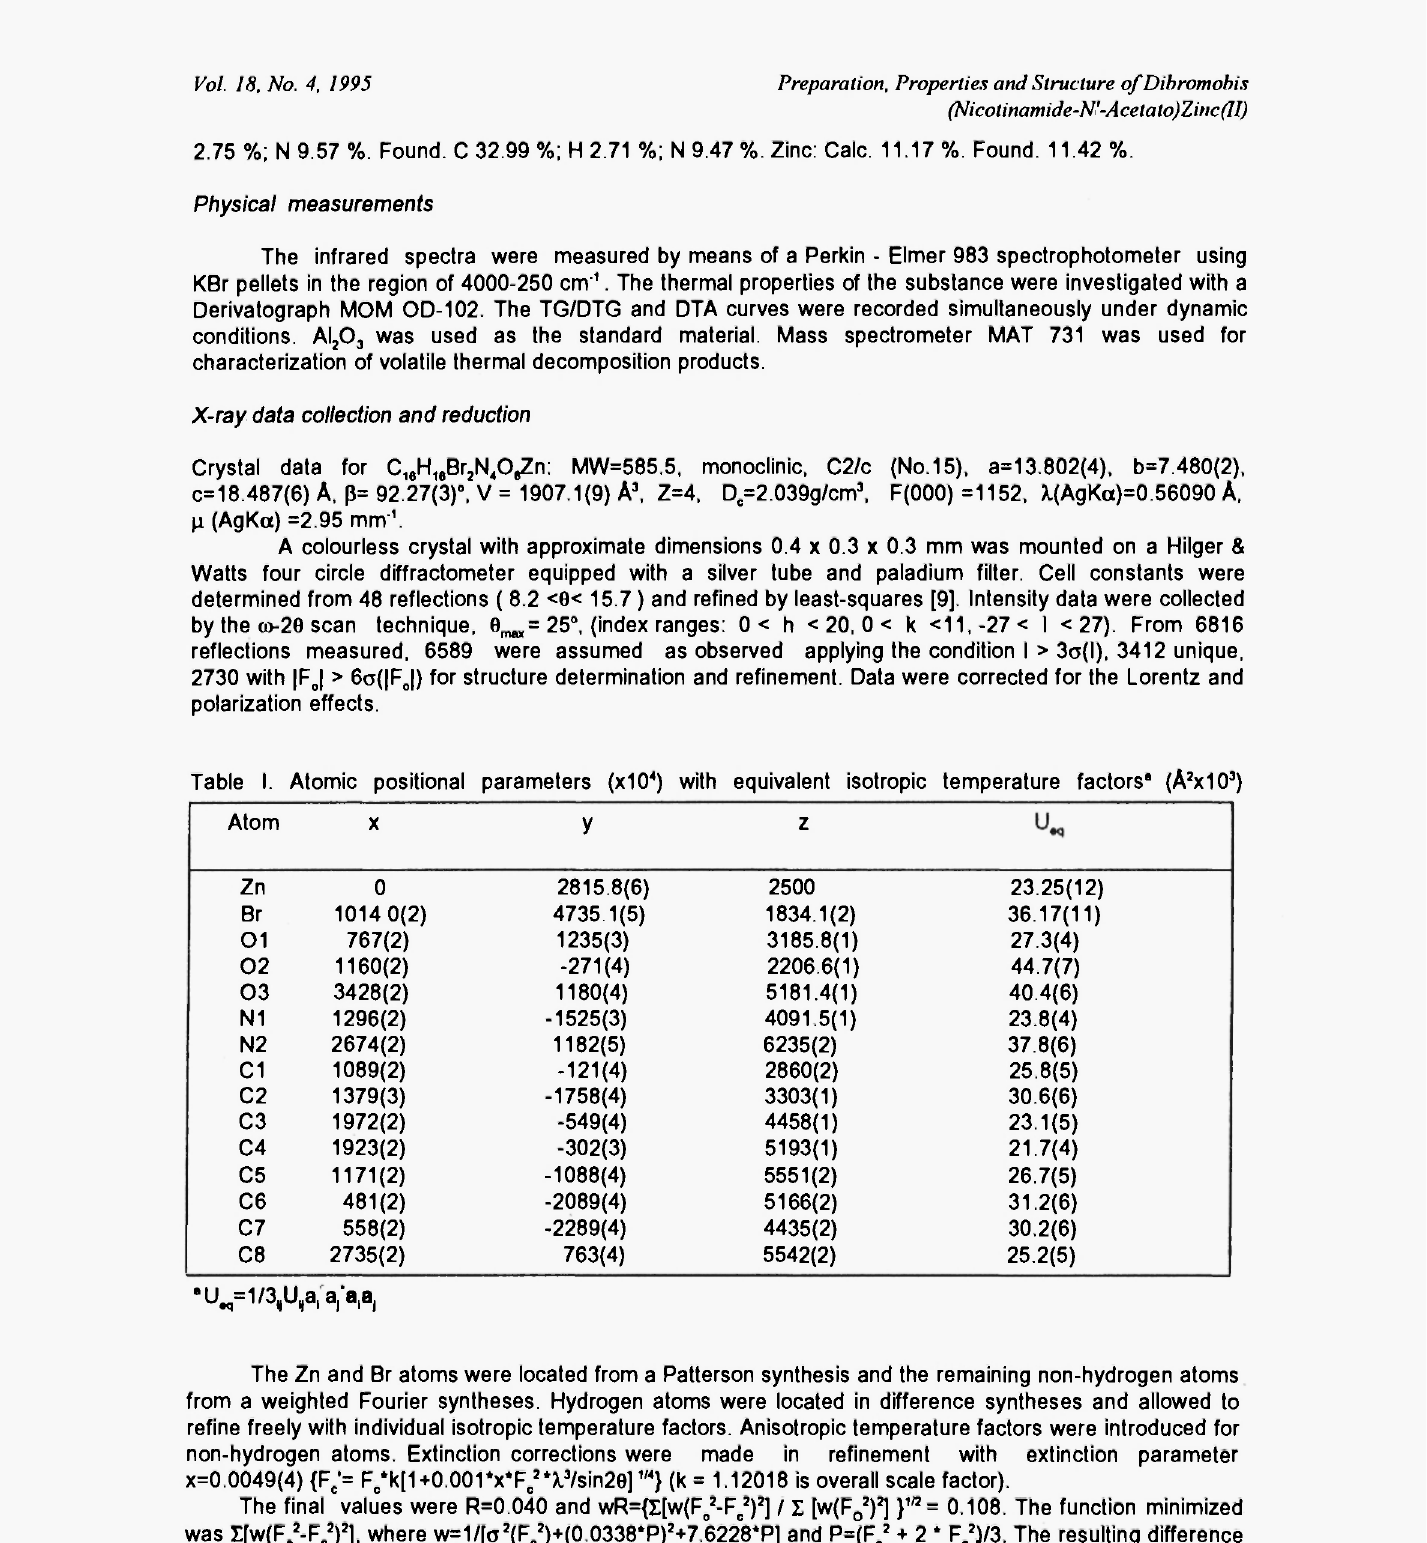
Figs. 1 and 2 were drawn with PLUTO [12], The final atomic coordinates with equivalent isotropic temperature factors are presented in Table I. Hydrogen atoms parameters are available as supplementary